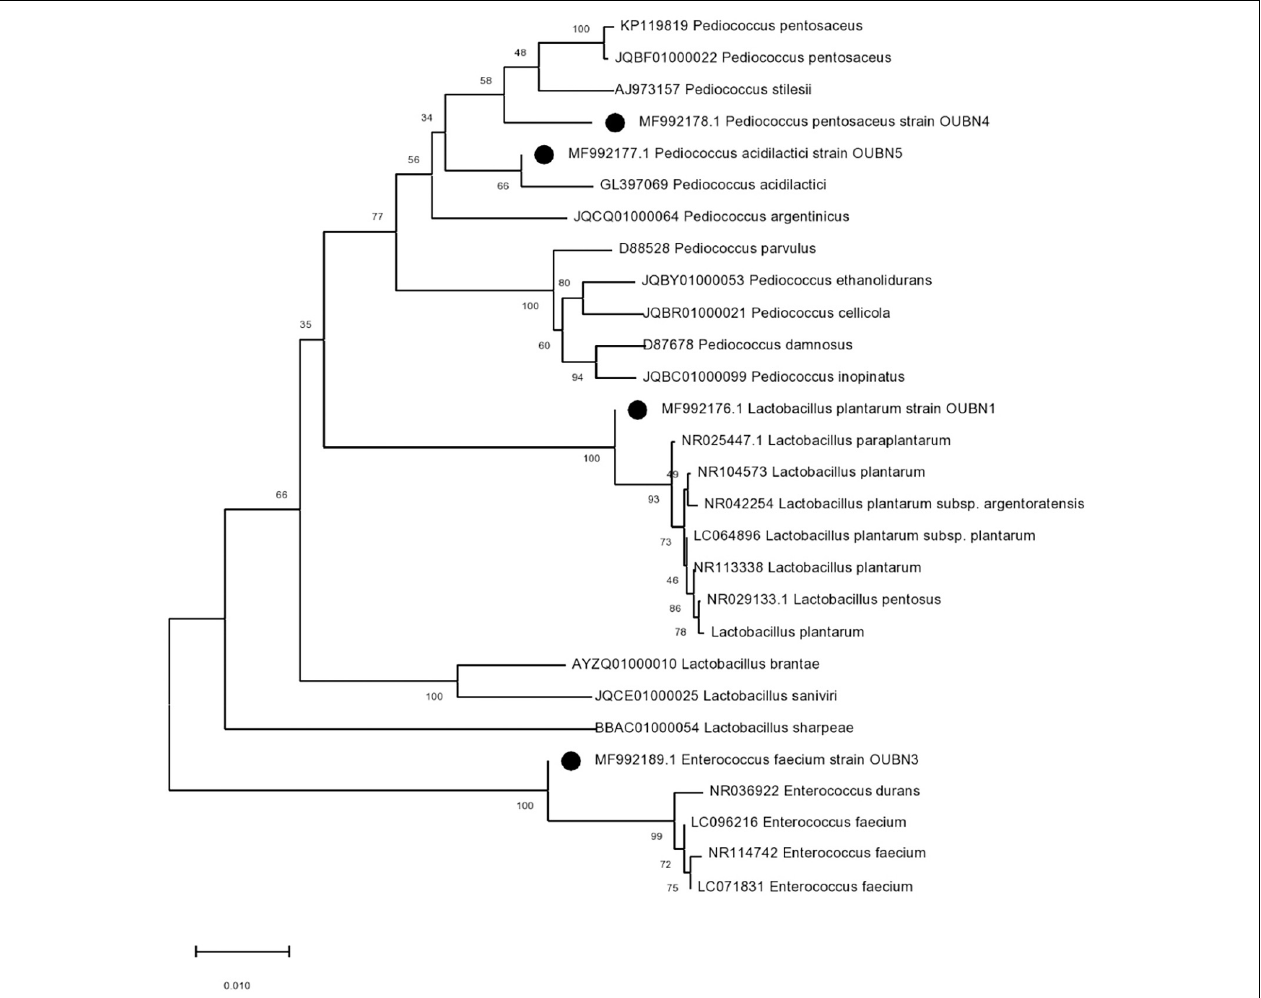
FIGURE 1 | Phylogenetic tree constructed by the neighbour-joining method showing the relative positions of LAB isolates (OUBN1, OUBN3, OUBN4, and OUBN5) based on 16S rRNA gene sequences from Palm toddy nectar samples. Evolutionary analyses were conducted in MEGA X. The tree is drawn to scale. The percentage of replicate trees in which the associated taxa are clustered together in the bootstrap test of 1,000 replicates is shown next to the branches. TABLE 4A | Viable cell count log cfu/ml of LAB survived in MRS broth at different pH and time intervals. LAB strains pH